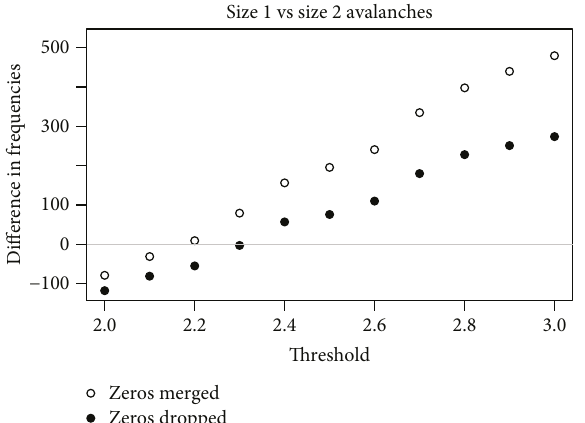
Figure 4: Kullback – Leibler divergence between the empirical and estimated avalanche distributions as a function of the dichotomization threshold (ignoring P values).